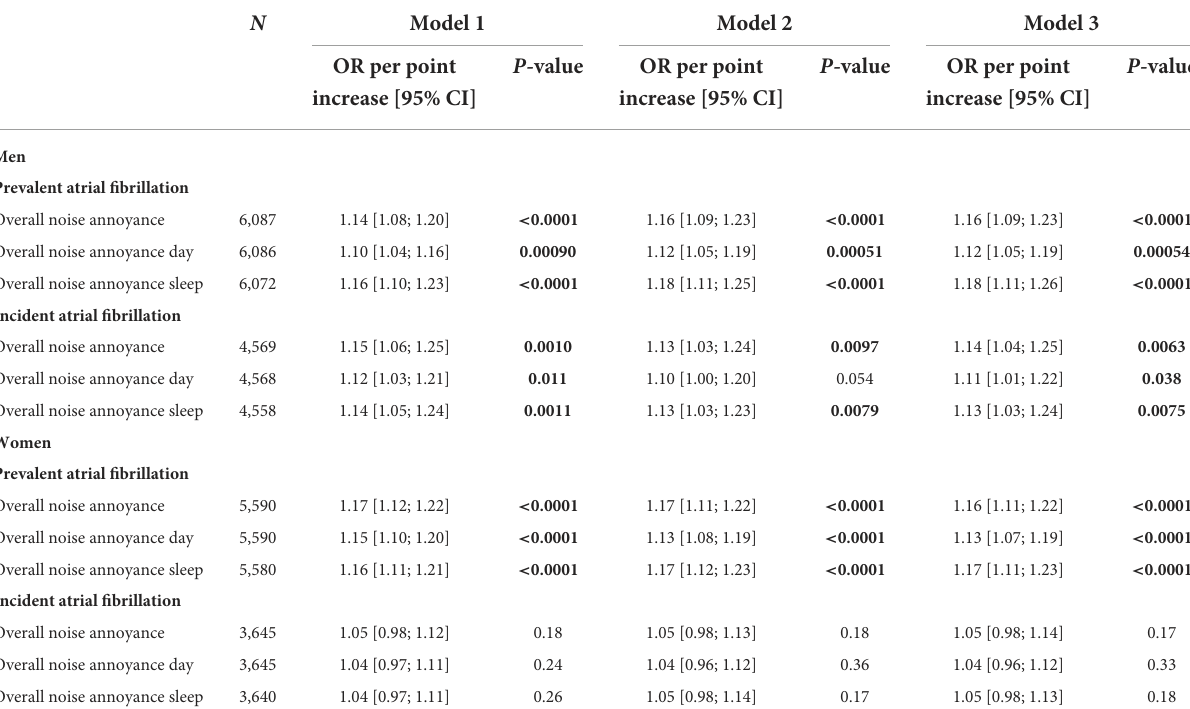
TABLE 4 Cross-sectional/prospective association analysis between overall noise annoyance and prevalent/incident atrial fibrillation in men and